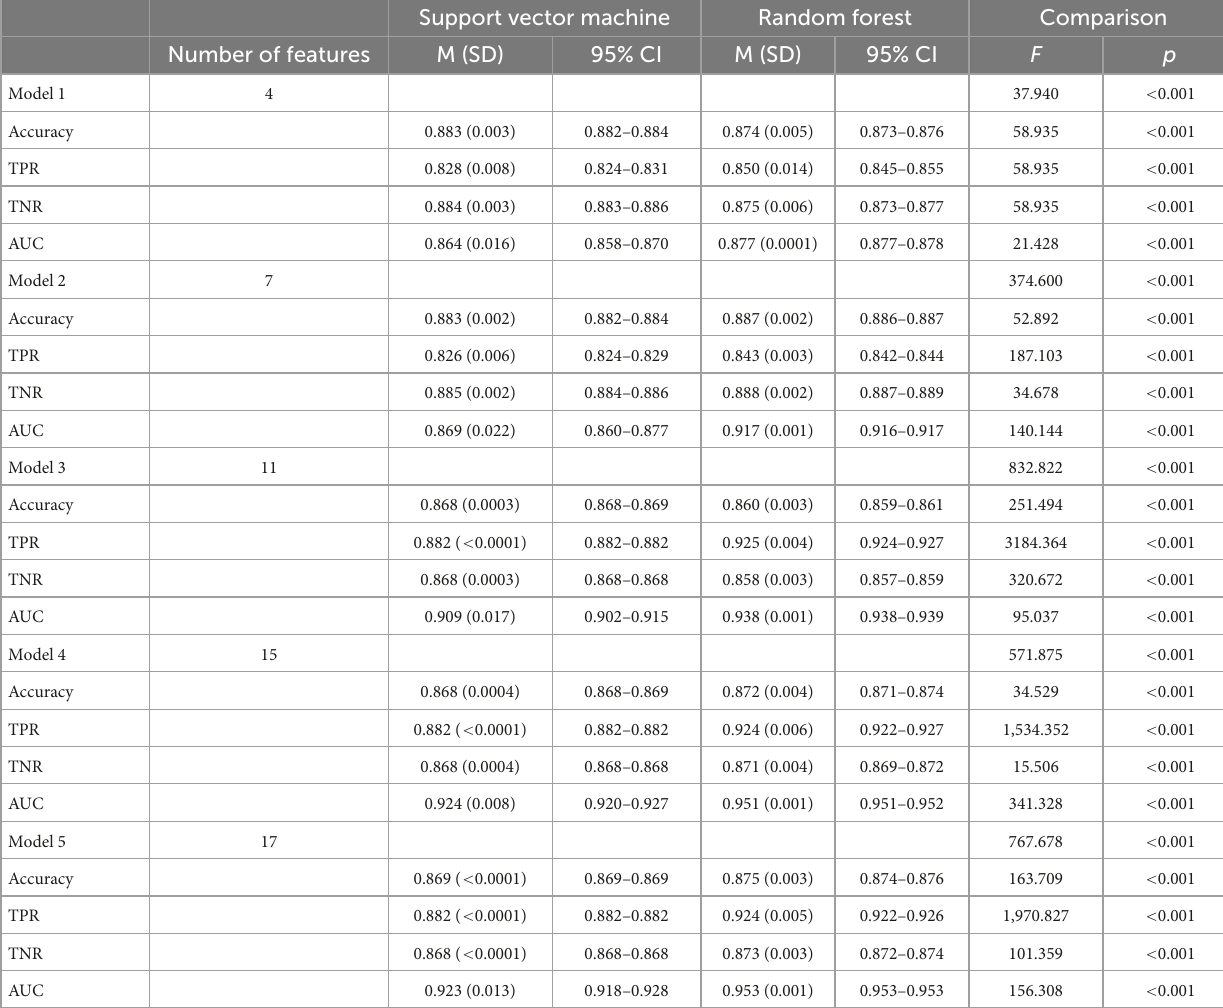
TABLE 1 Benzodiazepine prescription receipt (yes/no) prediction